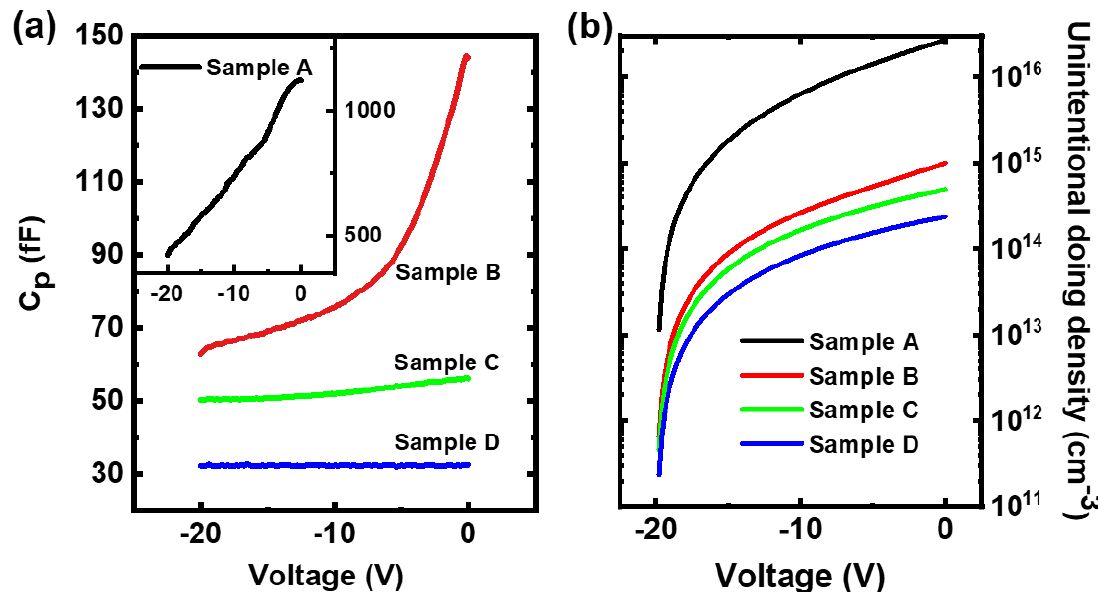
Figure 4. ( a ) Capacitance curves obtained for a Schottky Barrier Diode for all devices under negative bias. ( b ) The inferred unintentional doping curves for the four samples. Sample A has the highest capacitance, as high as the pF sort of range, which corre- sponds to the highest unintentional doping density. In addition, its increase in capacitance